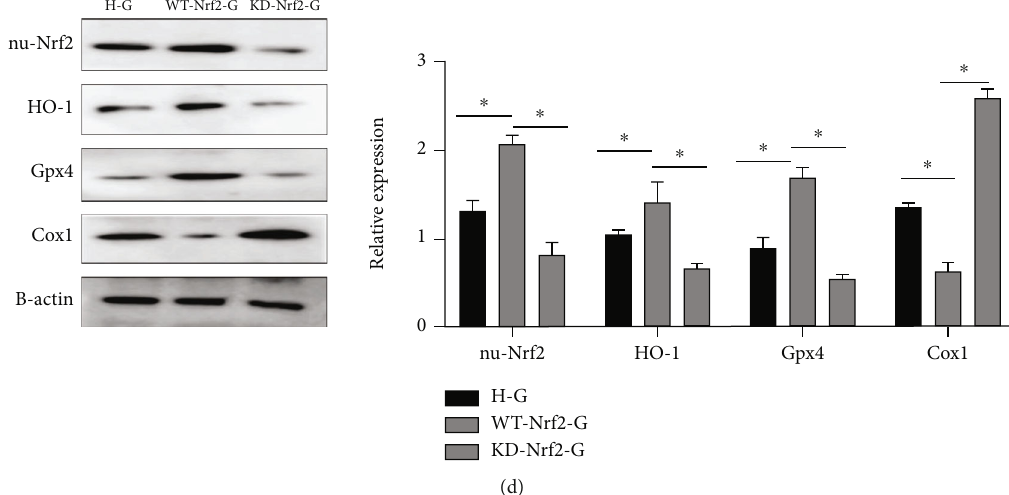
Figure 3: High glucose-induced cardiomyocyte damage can be alleviated by overexpression of Nrf2. H-G: 30 mmol/L glucose concentration; WT-Nrf2-G: Nrf2 overexpressing+30 mmol/L glucose concentration; KD-Nrf2-G: knockdown of Nrf2 expression+30mmol/L